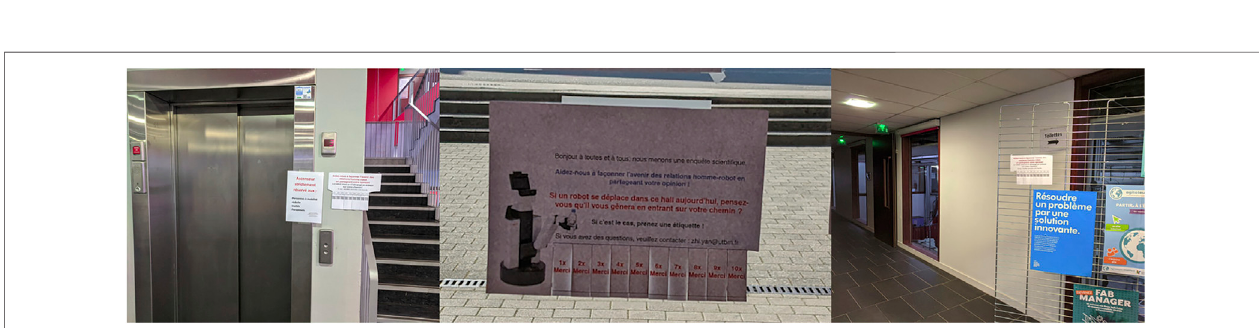
FIGURE 2 | Three paper sheets placed with removable tags near the three